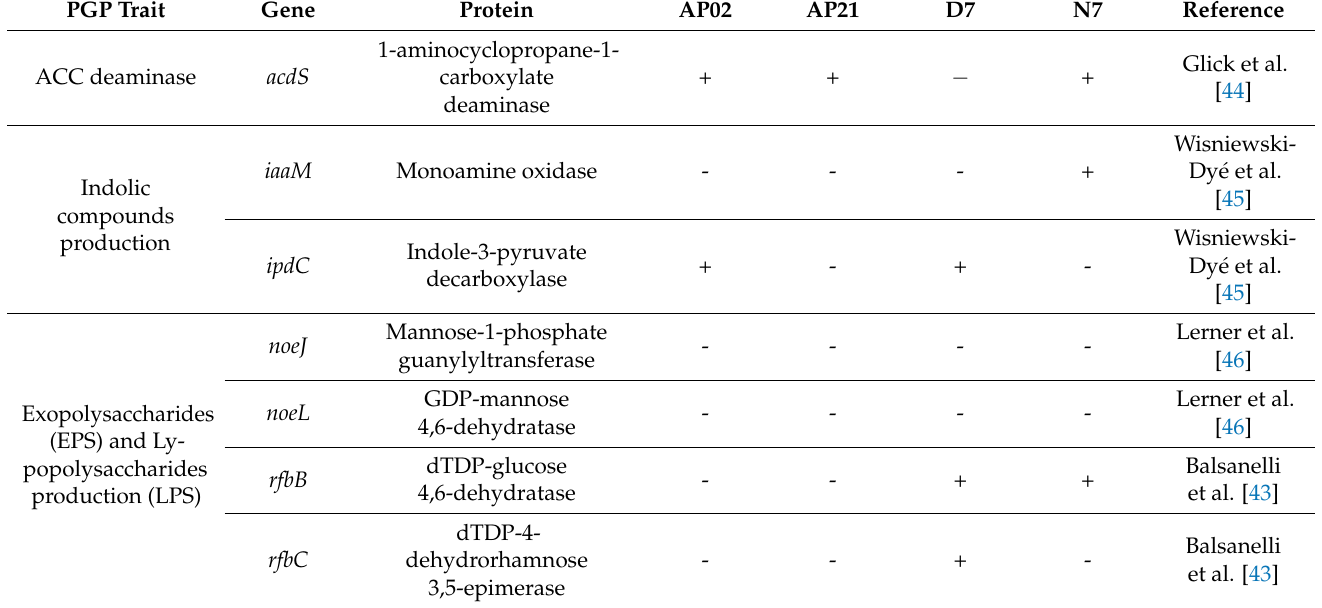
Table 1. Representative genes selected to explore the potential growth-promoting traits of the bacteria. AP02: Herbaspirillum sp.; AP21: Herbaspirillum sp.; D7: Azospirillum brasilense .; N7: Pseudomonas fluorescens . PGP, plant growth- promoting; ACC, 1-aminocyclopropane-1-carboxylate.